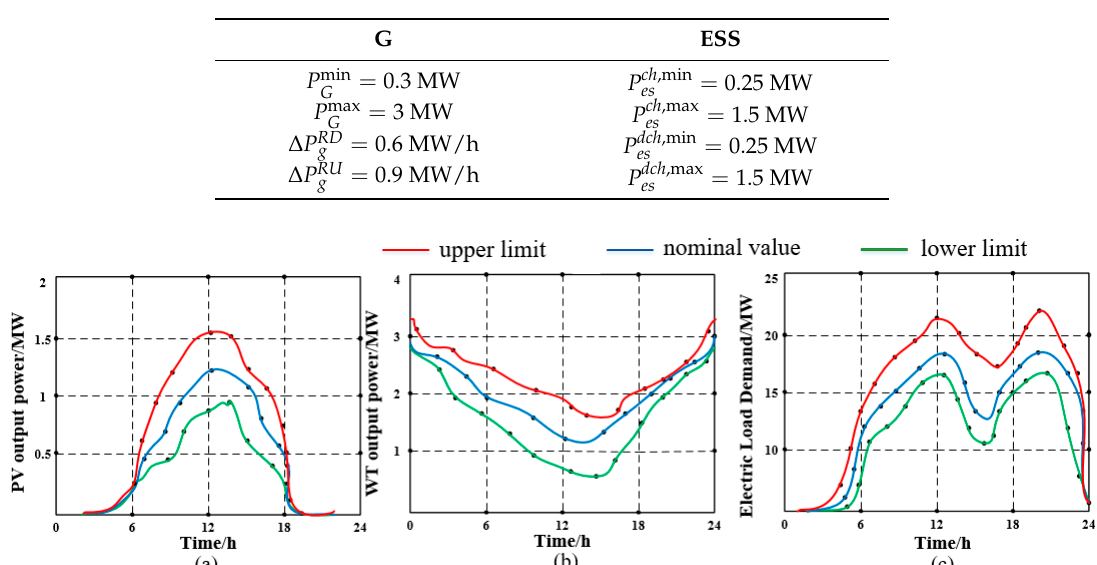
Figure 5. ( a ) The fluctuated curve of photovoltaic (PV) on Node-4; ( b ) The fluctuated curve of wind turbines (WT) on Node-7; ( c ) The fluctuated curve of total electric load demand.